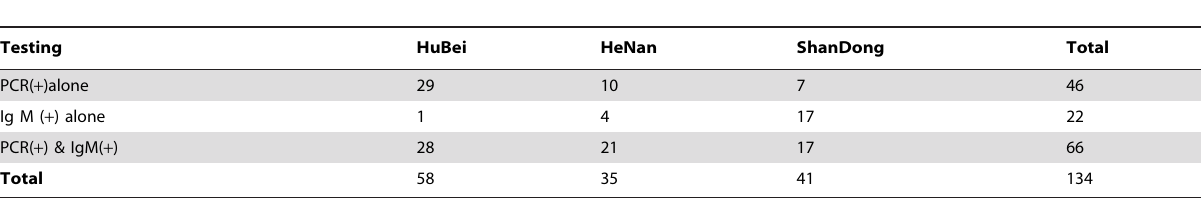
Table 2. Laboratory testing results of the SFTS patients (cases, N=